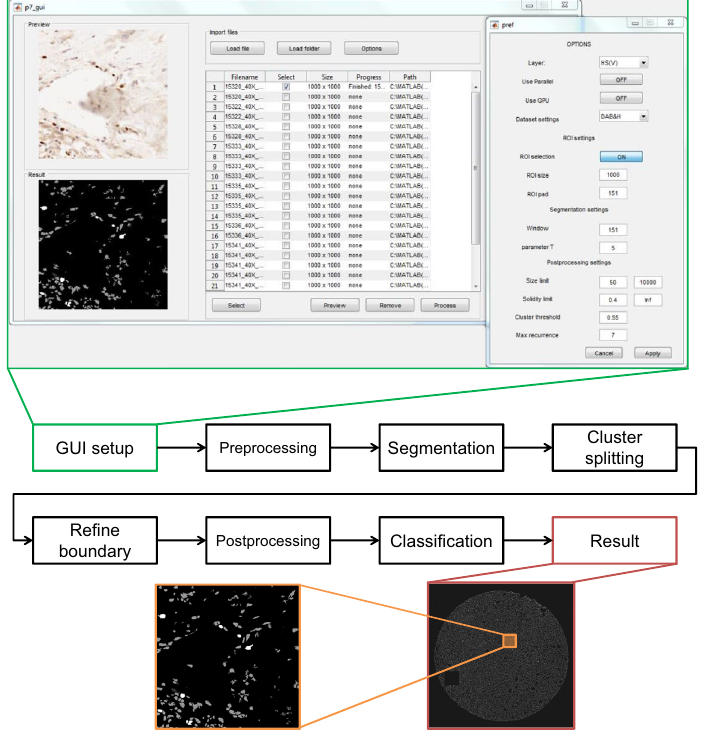
Figure 1. Schema of CHISEL system. GUI is presented above (green lines) with opened preferences submenu where user can modify most critical parameters influencing the processing. Below is presented an example of the resulting image of fragment of TMA (red lines) and its small 1000 × 1000 pixels zoomed fragment (orange lines) with multiclass output. Source code available on https:// github. com/ knave 88/ CHISEL/ [hi-res version of image available